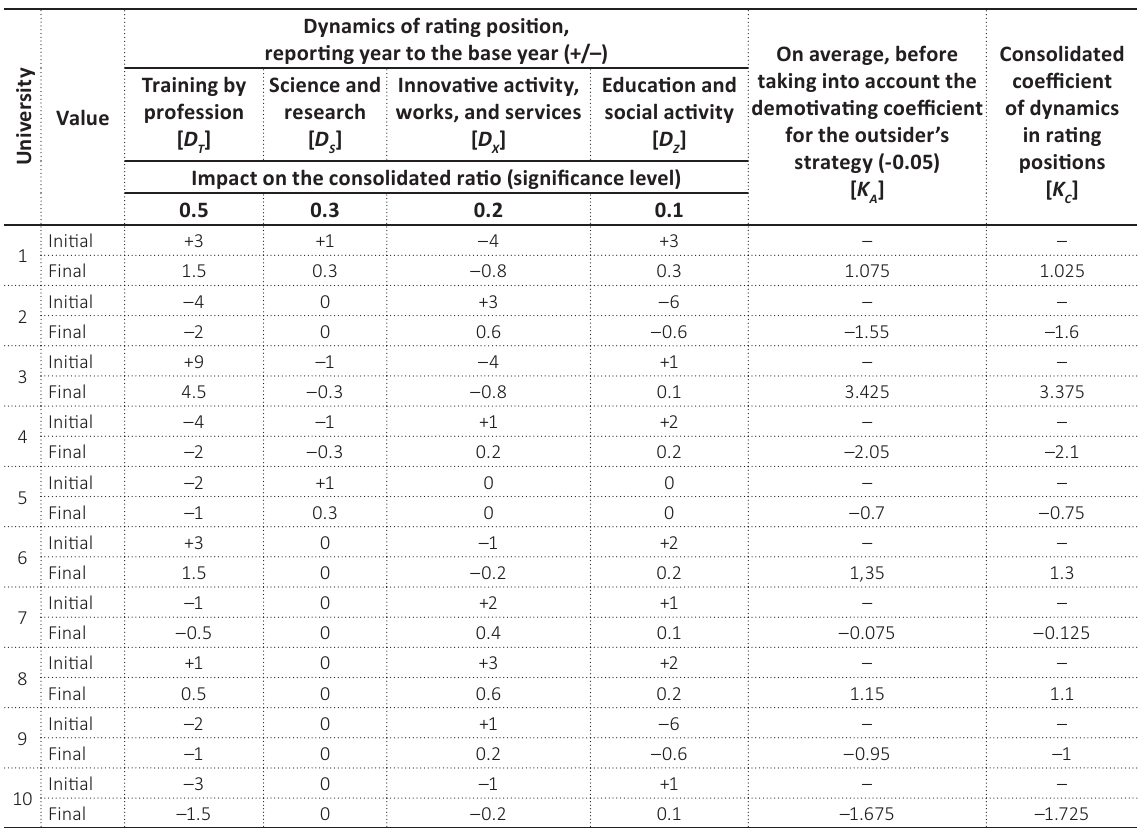
Table 2. Conversion of dynamics of rating positions of conditional institutions of higher education of Ukraine in the consolidated coefficient